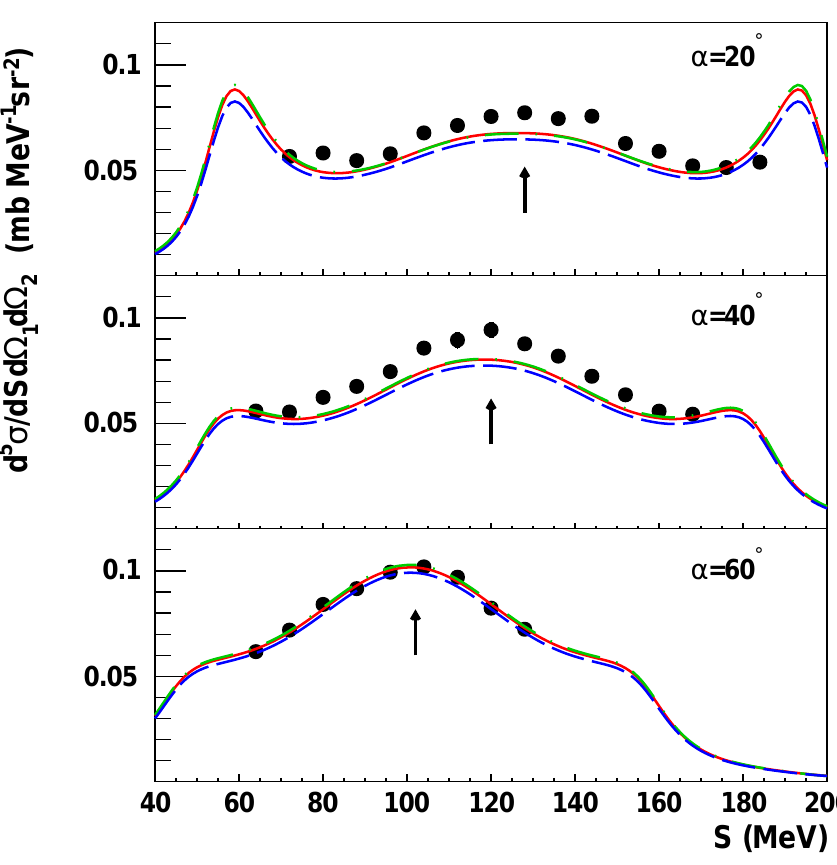
Figure 1: Deuteron breakup cross-section (d(160 MeV) + p → p + p + n) for 3 differ- ent values of α . Cross-section distributions are plotted against the value of the arc length along the kinematics ( S ) with the starting point ( S = 0) chosen arbitrarily at the point where E reaches minimum (see Fig. 2). The central value corresponds 2 to the star configuration (arrow). The theoretical predictions are plotted as lines (red solid: CD-Bonn + ∆ + Coulomb, green chain: CD-Bonn + ∆ , blue dashed: CD- Bonn + Coulomb) [ 5,15 ] . The normalisation of the experimental data is not finalised and does not contain e.g. effects due to